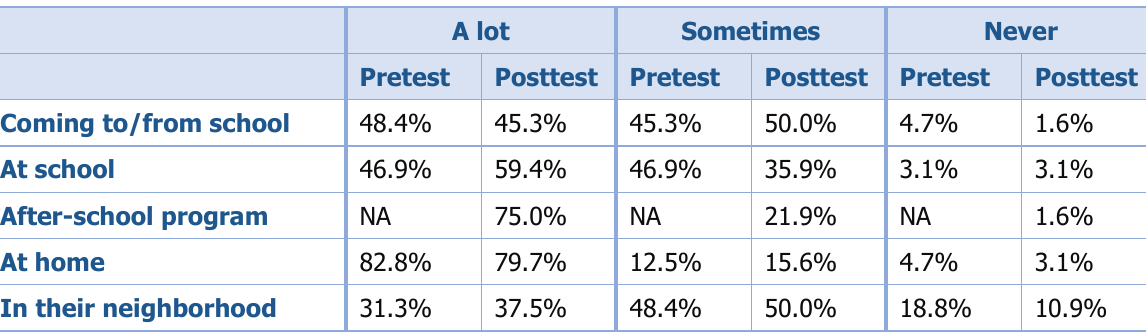
Table 2. Students’ Perceptions of Feeling Safe Before and After the Program A lot Sometimes Never Pretest Posttest Pretest Posttest Pretest Posttest Coming to/from school 48.4% 45.3% 45.3% 50.0% 4.7% 1.6% At school 46.9% 59.4% After-school program NA At home In their